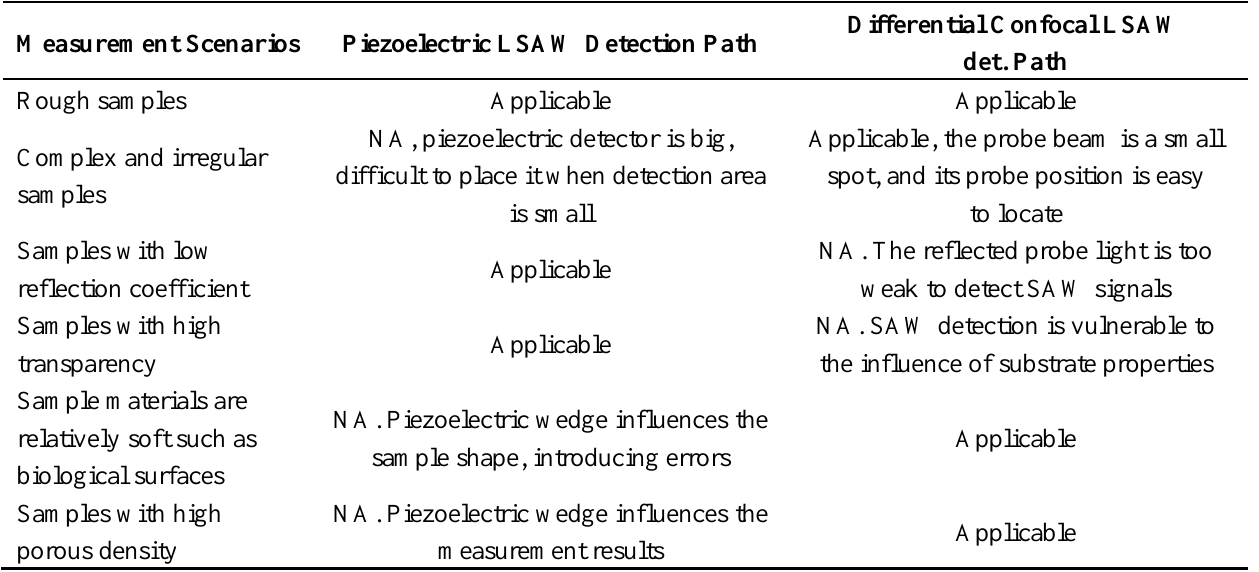
Table 2. Application guidelines of the integrated laser-induced PZT/DC SAW